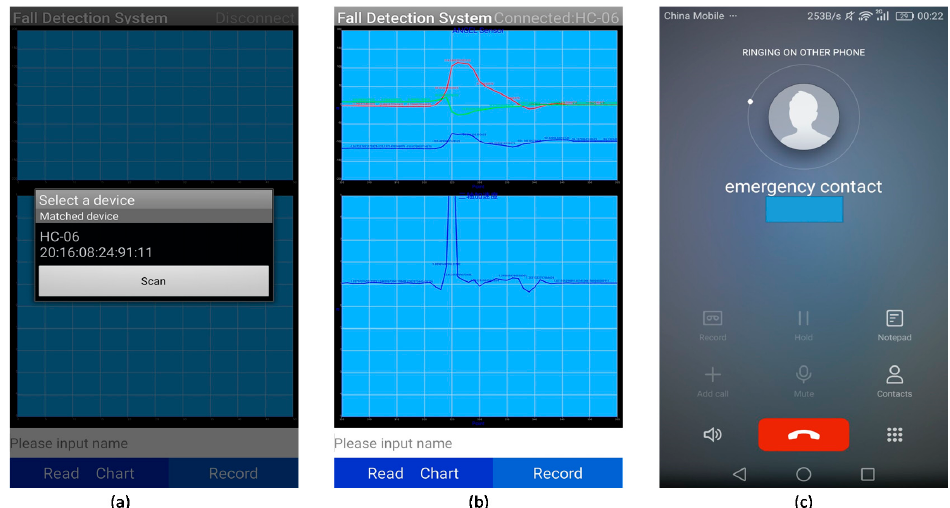
Figure 3. Main interfaces of the Android application: ( a ) device search; ( b ) data visualization and fall monitor; ( c ) making alarm and automatic calling.